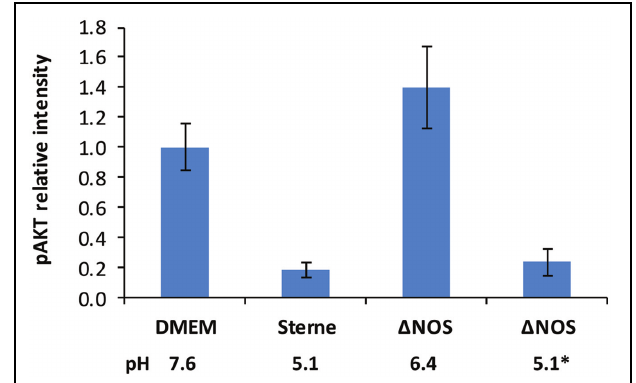
FIGURE 4 | Effect of Sterne and (cid:2) NOS sups grown in microaerobic conditions on phosphorylation of AKT (S473) in HSAECs. The cells were exposed for 2 h to the sups of bacterial cultures grown for 24 h in static conditions. Corresponding pH values of the sups are shown. The lysates of the cells were used for western blots with a primary rabbit antibody against phosphorylated form of AKT (S473) and a secondary anti-rabit antibody conjugated with horseradish peroxidase. The activity of peroxidase in the bands was detected using a SuperSignal West Femto chemiluminescent substrate (Pierce) and quantitated with a digital camera. To take into account the effect of pH the (cid:2) NOS sup after cultivation was titrated from pH 6.4 to pH 5.1 indicated by an asterik. Error bars show 95% confidence intervals obtained from three independent western blots. The preparation of the lysates was repeated twice with similar